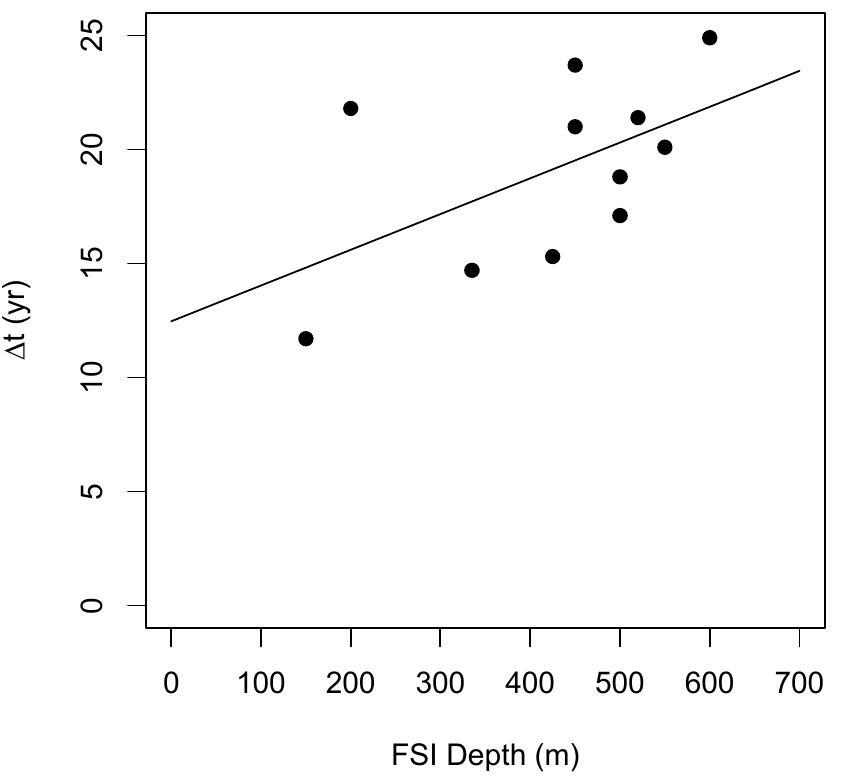
Figure 7. Linear regression between ∆ t and FSI depth shows a slope of 0.016 yr/m with R 2 = 0.30.